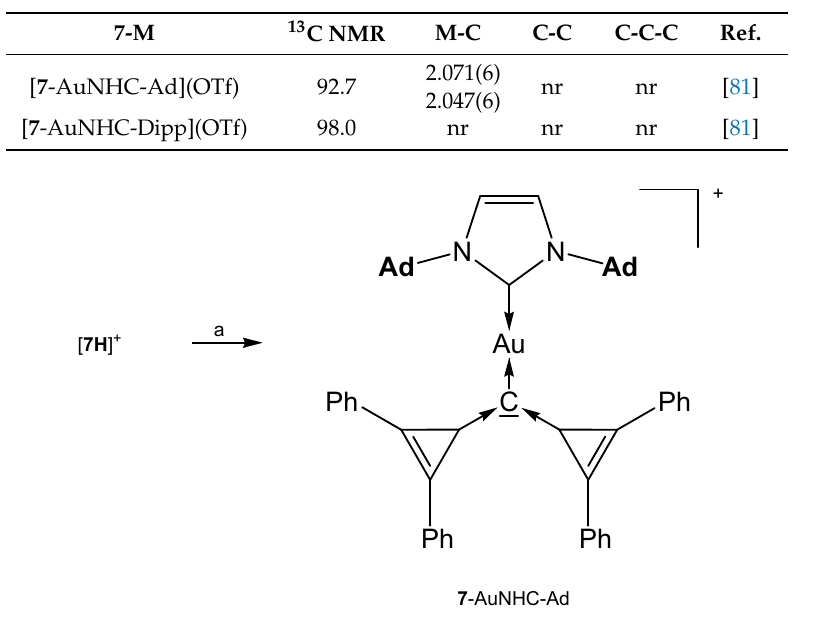
Scheme 15. Selected structures of complexes with the cyclo propylidene stabilized carbone